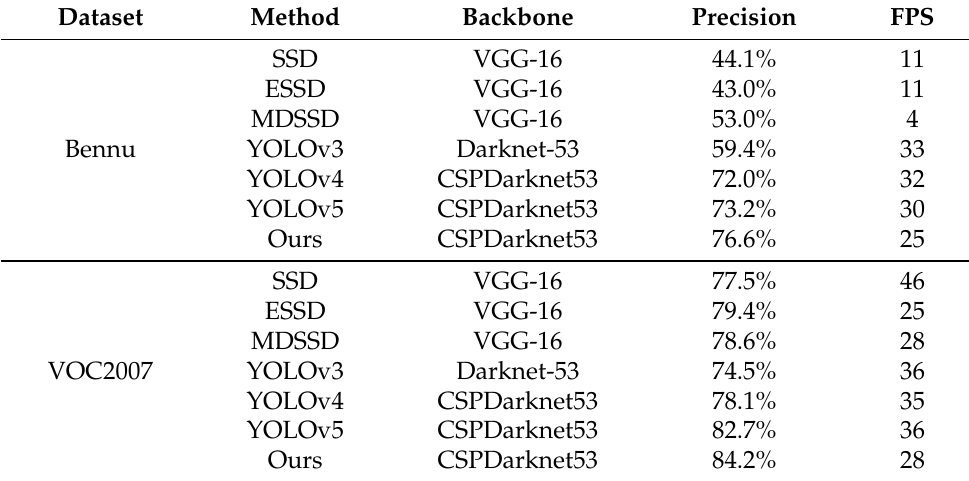
Table 1. The comparison results with related methods.